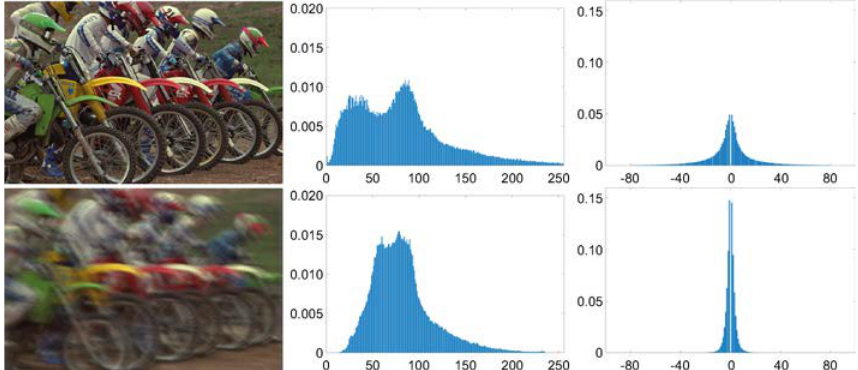
Figure 1. Example of the histograms on a clear and blurred image. First column: the upper is a clear image and the lower is a motion-blurred image. Second column: statistics of pixel value distributions in the two images. Third column: statistics of nonzero value distributions in the gradient domains of the images ( x -axis represents the pixel value, y -axis represents the statistical